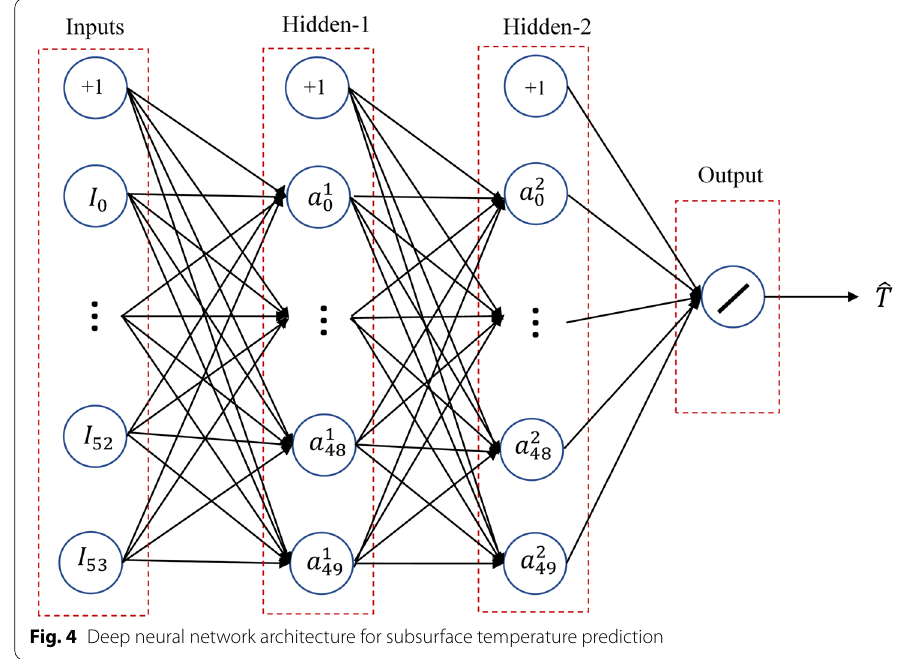
Fig. 4 Deep neural network architecture for subsurface temperature